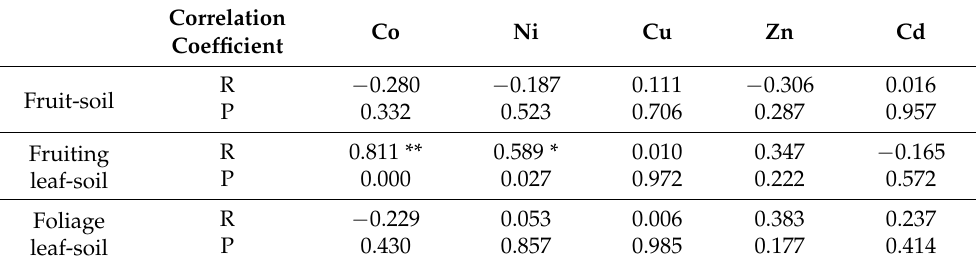
Table 3. Correlation coefficients of heavy metal elements among winter jujube organs and soils.